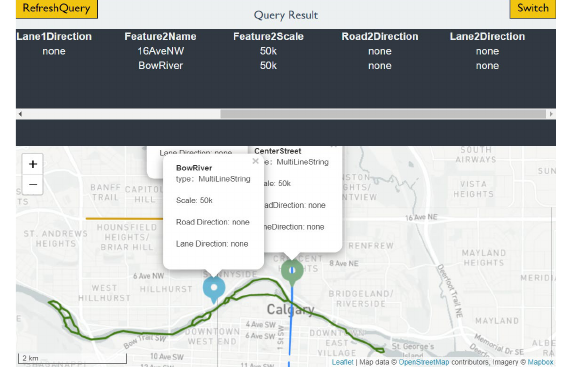
Figure 11 . Results of geometries intersecting with CenterStreet at 1:50k.